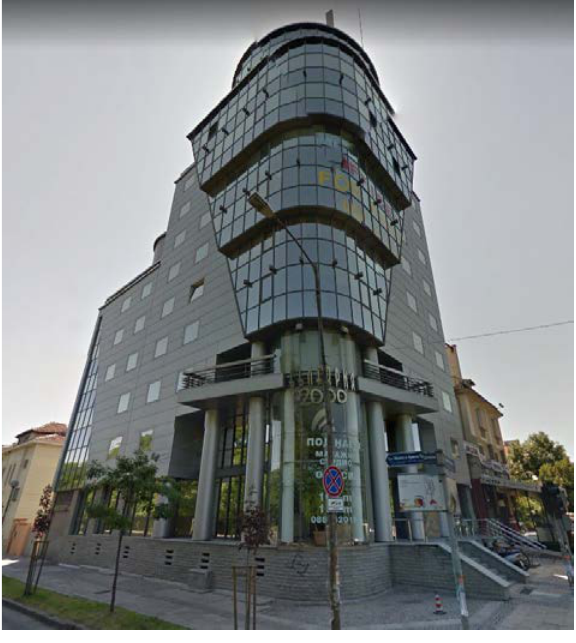
Figure 7: The building in a parcel 68134.902.236